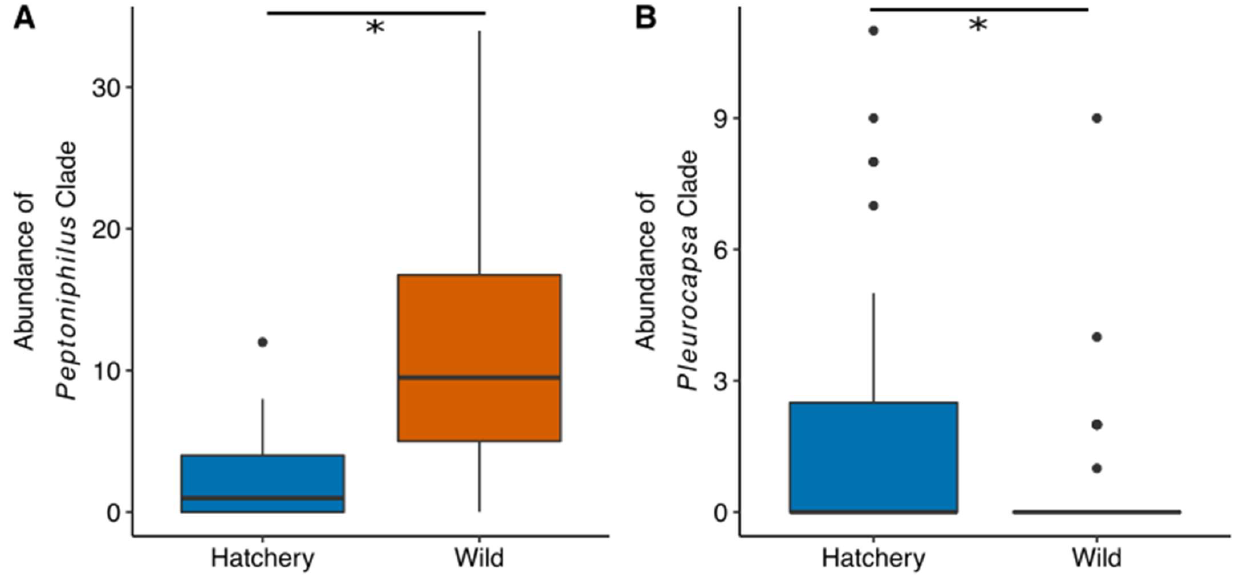
Figure 6. Examples of gut bacterial clades that are more abundant in either traditional hatchery or wild broodstock fish. Asterisk (*) indicates a statistically significant result using Kruskal-Wallis tests and false discovery rate multiple test correction. ( A ) This Peptonophilus clade example is more abundant in wild broodstock fish guts. ( B ) The Pluerocapsa clade example is more abundant in traditional hatchery broodstock fish.